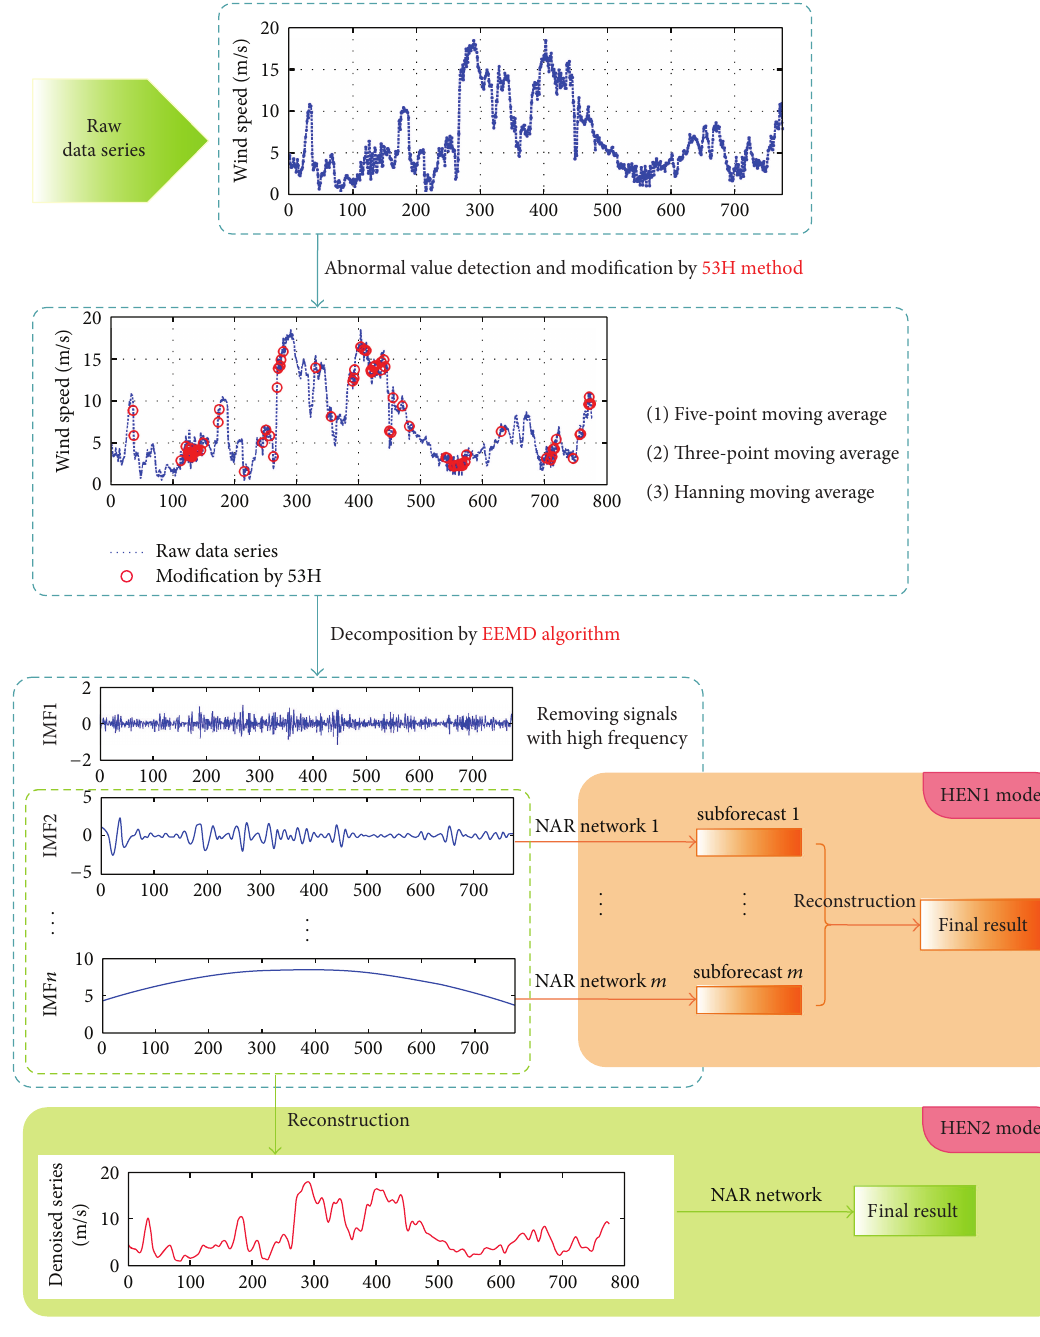
Figure 2: The flowchart of the proposed